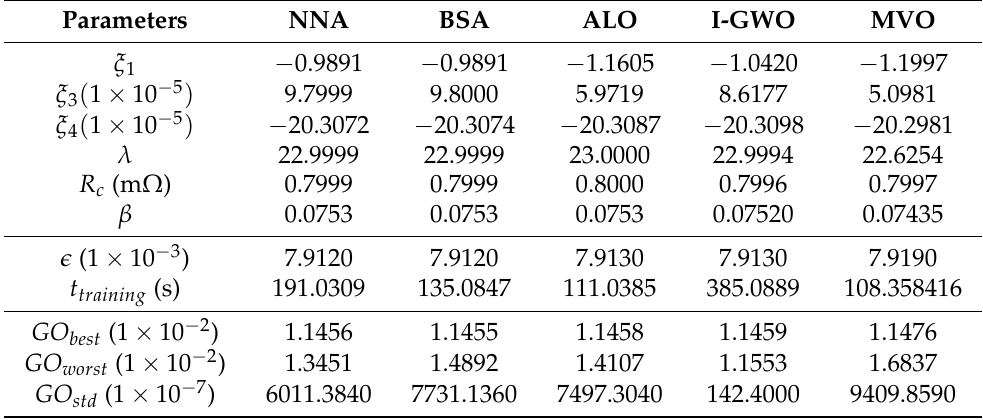
Table 7. Unknown parameters computed and performance information for the modeled polarization curve at 43% RH.